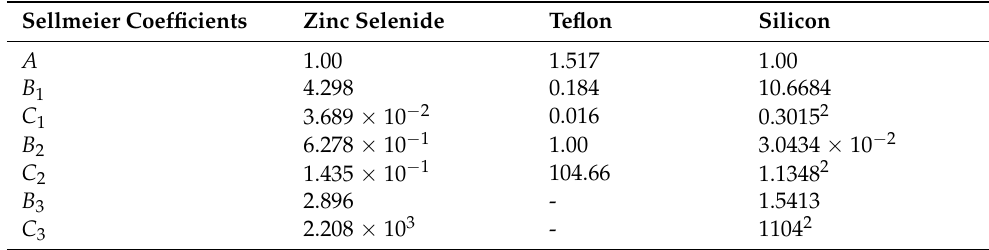
Table 1. The experimentally derived Sellmeier coefficients for ZnSe, Teflon, and Si.